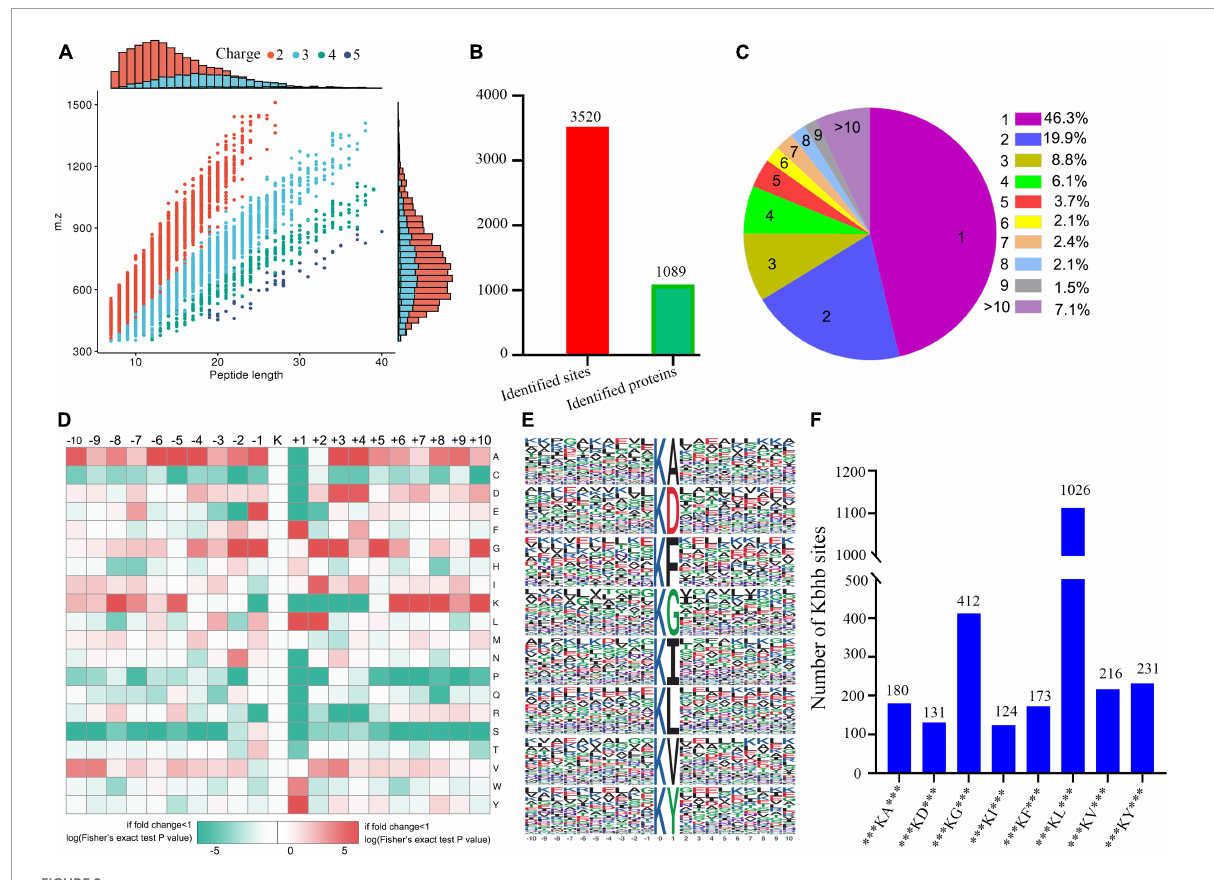
FIGURE2 Properties of the lysine β -hydroxybutyrylation (kbhb) sites. (A) Distributions of peptide length for all the β -hydroxybutyrylation sites identified in the rats ( n = 3 rats per group). (B) The number of identified sites and proteins. (C) A pie chart of the number and percentage of β -hydroxybutyrylation residues per protein. (D) A heat map of the ± 10 amino acid compositional frequencies surrounding the β -hydroxybutyrylation residues. (E) The modified peptide motifs containing ± 10 amino acids surrounding the identified residues. (F) The number of β -hydroxybutyrylation sequence